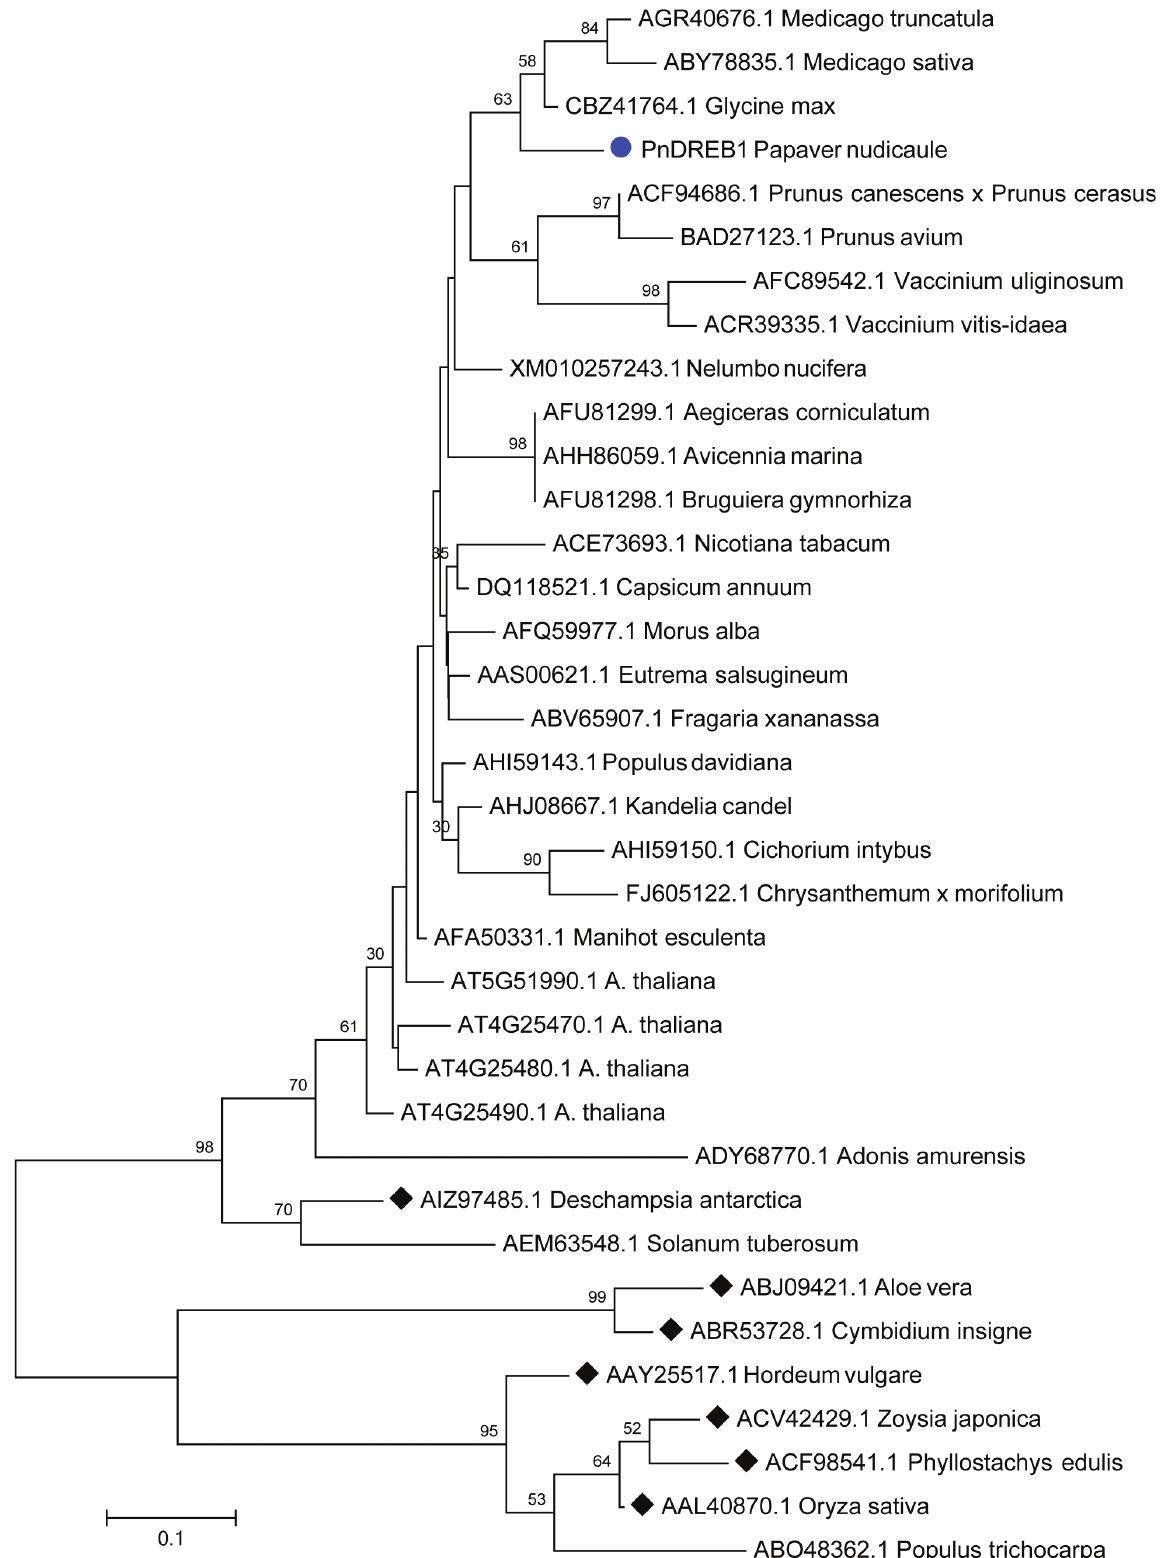
Figure 4 - Phylogenetic tree based on the deduced amino acid sequences of AP2/ERF domain of 35 DREB1s. The tree is constructed by maximum likeli- hood method with 1000 bootstrap replications. Before tree reconstruction, a model test was performed. The model with the lowest BIC scores (Bayesian InformationCriterion),theJones-Taylor-Thornton(JTT)modelwithparametersofGammadistribution(+G)with5ratecategoriesforRatesandPatterns were chosen. Diamonds indicate the monocot